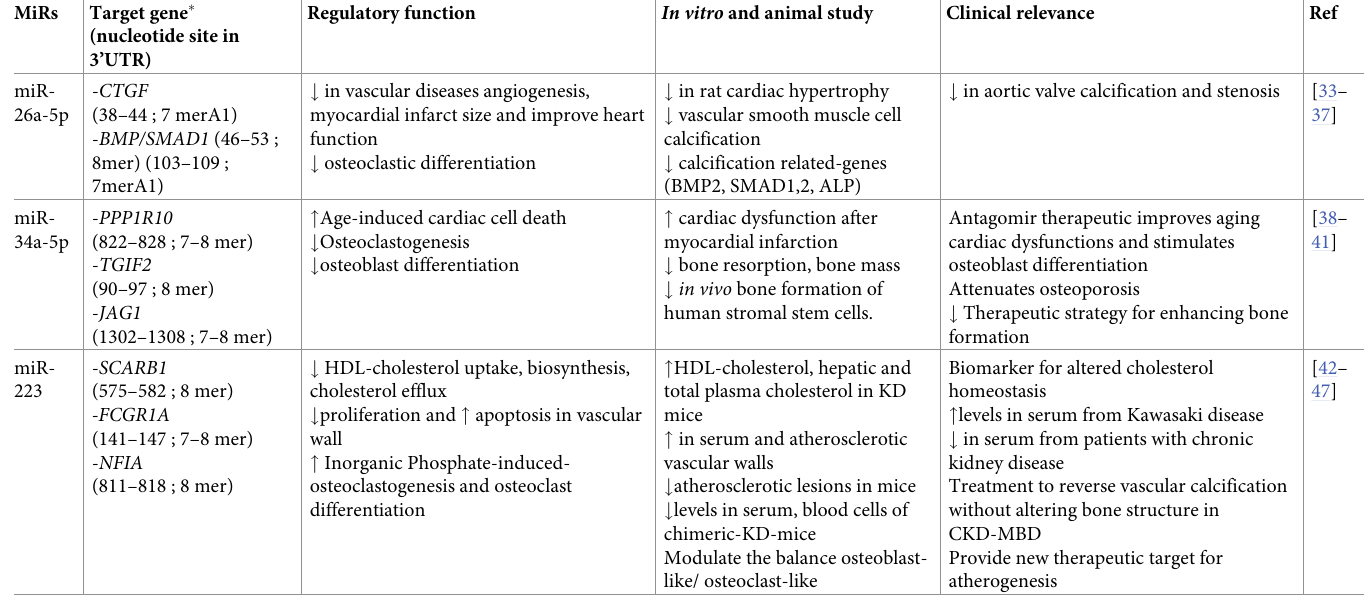
� : The target genes are indicated with the nucleotide position of the seed region in the 3’-UTR (according to Target Scan). " # are for up- and -down regulation